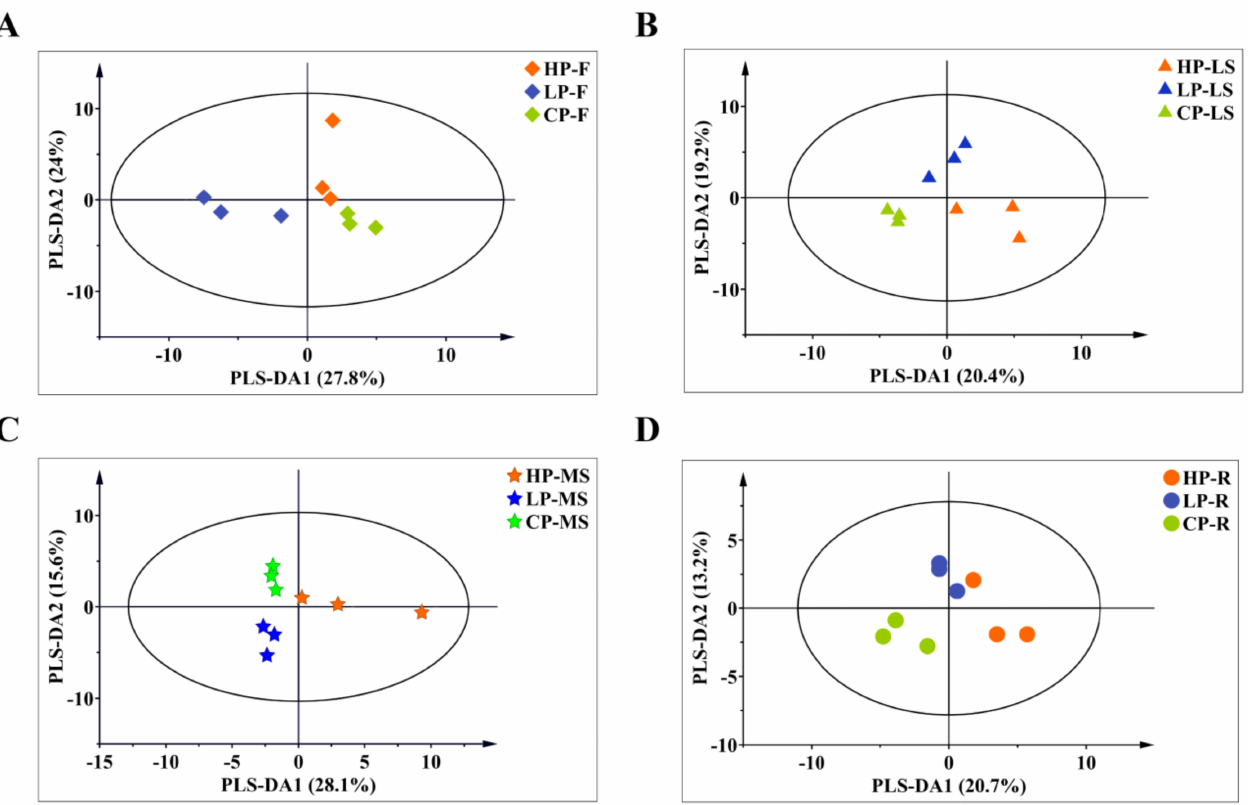
Figure 5. Score plots of PLS − DA for metabolites variation in flowers ( A ), lateral shoots ( B ), main shoots ( C ) and roots ( D ). Different markers and colors represent different meanings; • , (cid:117) , (cid:78) , (cid:70) represent roots (R), flowers (F), lateral shoots (LS), main shoots (MS), respectively; and red, green and blue represent high phosphorus (HP), low phosphorus (LP) and control phosphorus (CP),